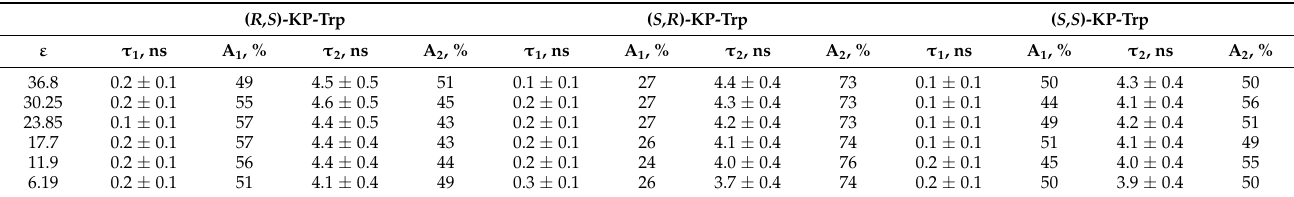
Table 2. Fluorescence lifetimes for three optical configurations of the KP-Trp dyad at different dielectric constants of the solvent (mixtures of